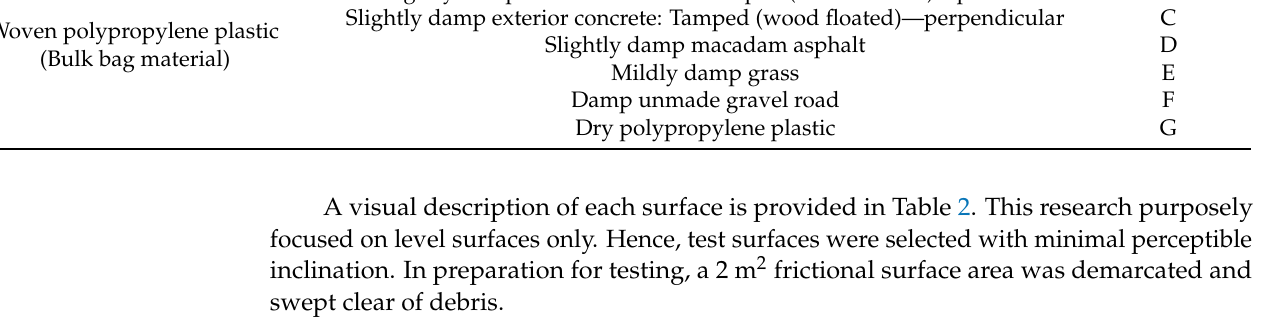
Table 2. Description of frictional surfaces tested within the fieldwork